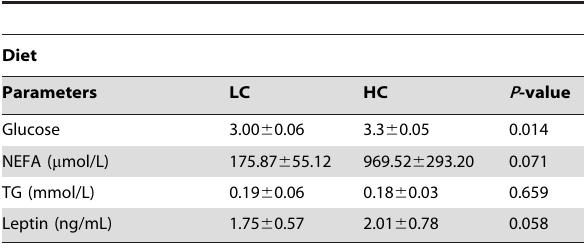
Table 1. Comparison of plasma concentrations of glucose, non-esterified fatty acids (NEFA), triglyceride (TG) and leptin.